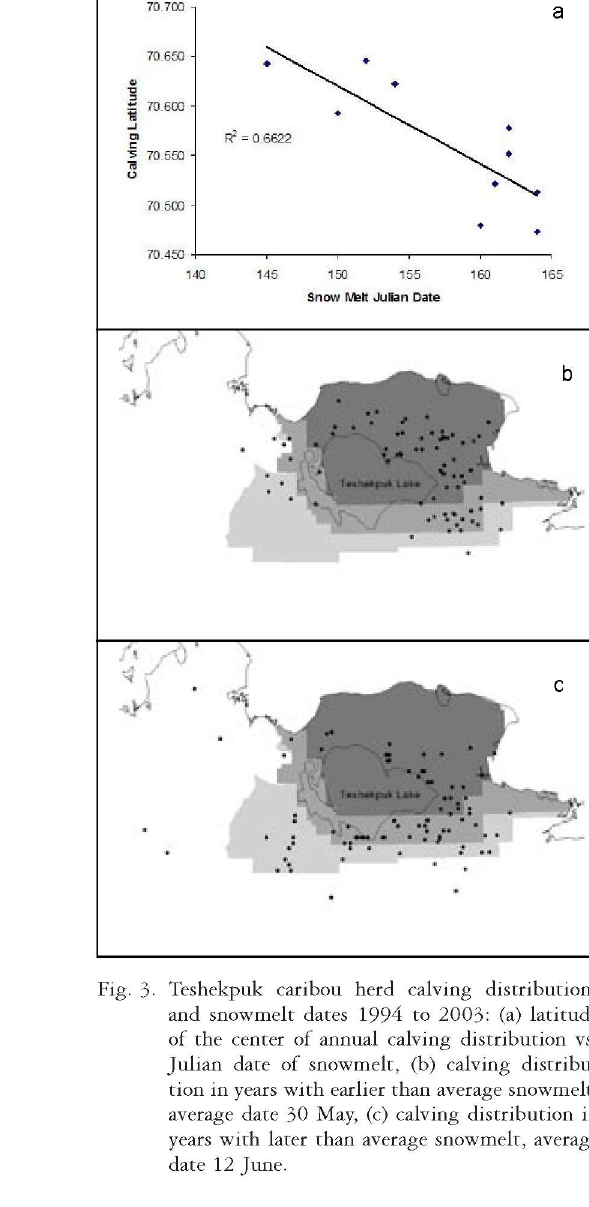
Fig. 3. Teshekpuk caribou herd calving distributions and snowmelt dates 1994 to 2003: (a) latitude of the center of annual calving distribution vs. Julian date of snowmelt, (b) calving distribu tion in years with earlier than average snowmelt, average date 30 May, (c) calving distribution in years with later than average snowmelt, average date 12 June.